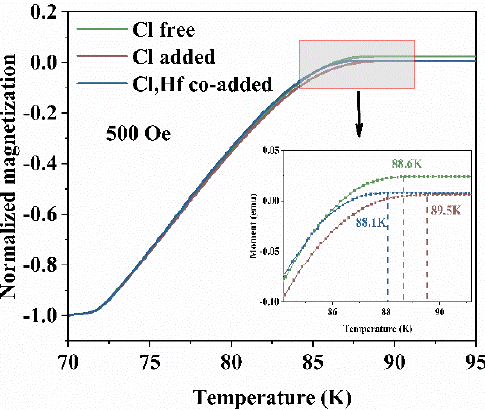
Figure 4. Normalized magnetization intensity curves with temperature for YBCO films Cl-free, Cl-added and (Cl, Hf) co-added.